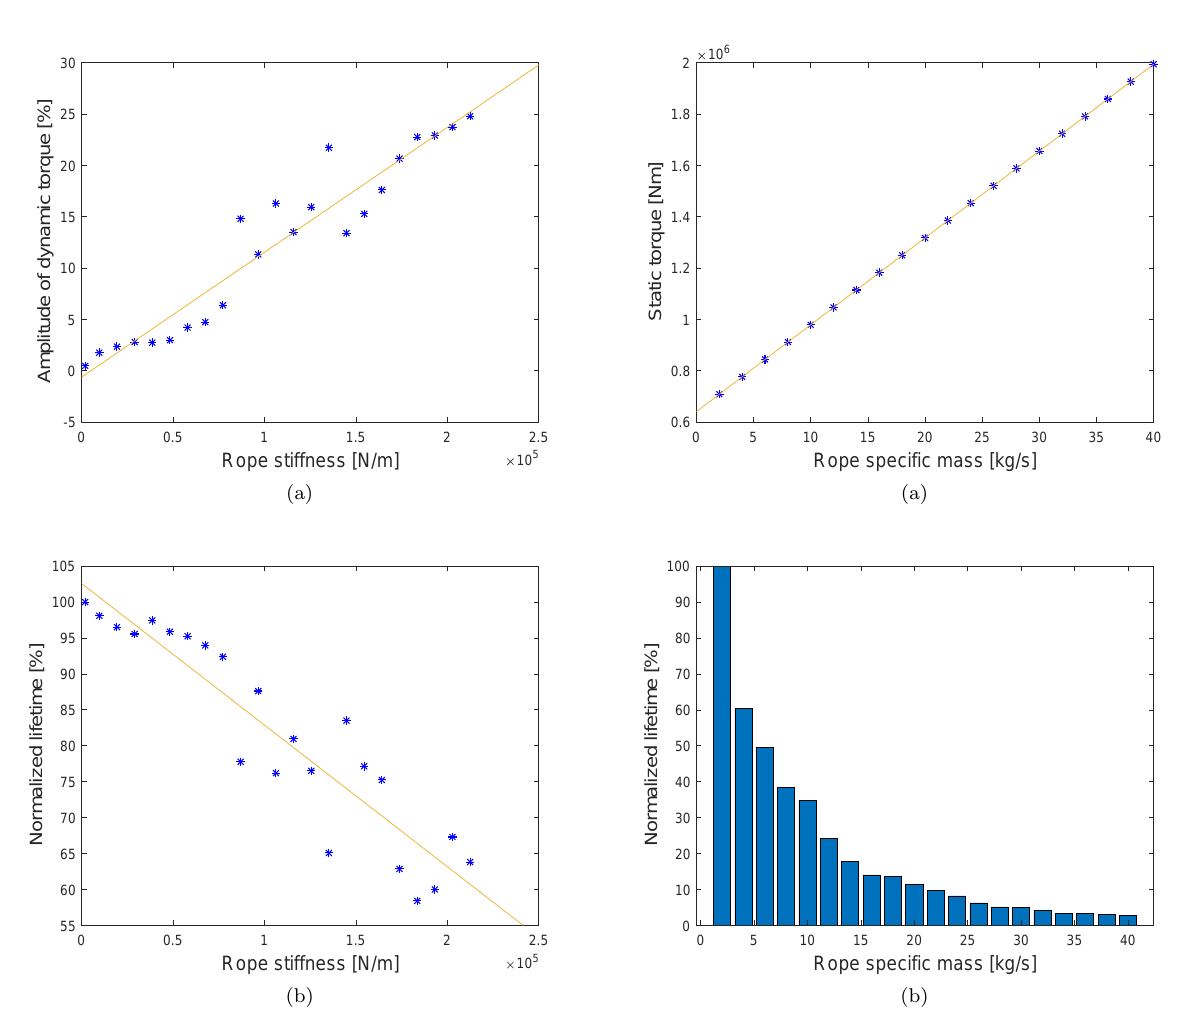
Figure 9: Effect of rope stiffness on amplitude of dy- namic torque (top) and normalized lifetime (bottom)